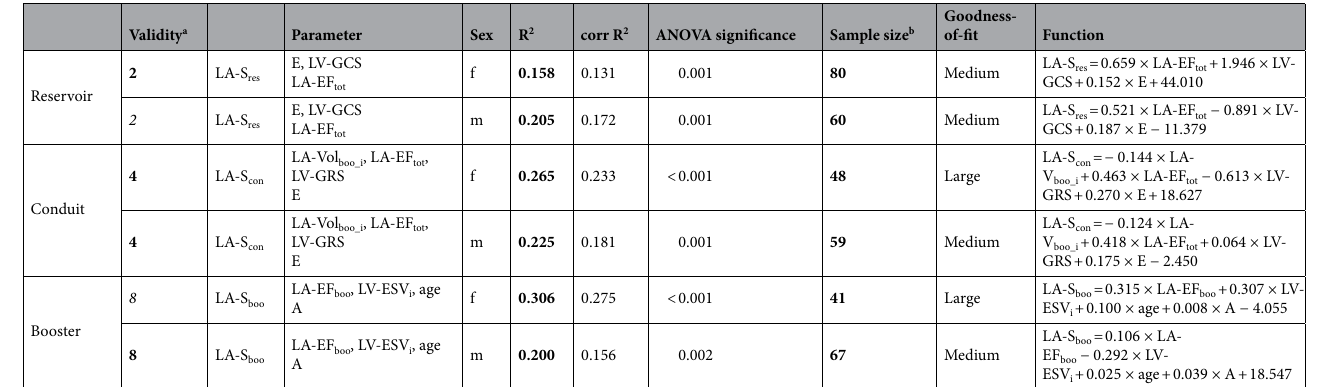
for females and a higher R 2 value of 0.320 for males was found for the subgroup. A comprehensive summary of the multiple linear regression analyses performed in the subgroups is given in Supplementary Table S2c,d. Intra‑ and interobserver variability. Intra- and interobserver variability was tested on 20 randomized subjects. All intra- and interobserver variability resulted in excellent intra-class-correlation coefficients (ICC > 0.9) and low coefficient of variation (CoV) for intra- and interobserver variability of < 10%. The high- est intra- and inter-observer resemblance were for reservoir strain (ICC 0.967 and 0.965), whereas the lowest intra- and inter-observer variations was for booster strain (ICC 0.941 and 0.936). The lowest bias and scatter by Bland–Altman statistics was found for the intra-observer reservoir strain, with a mean difference (95% confi-